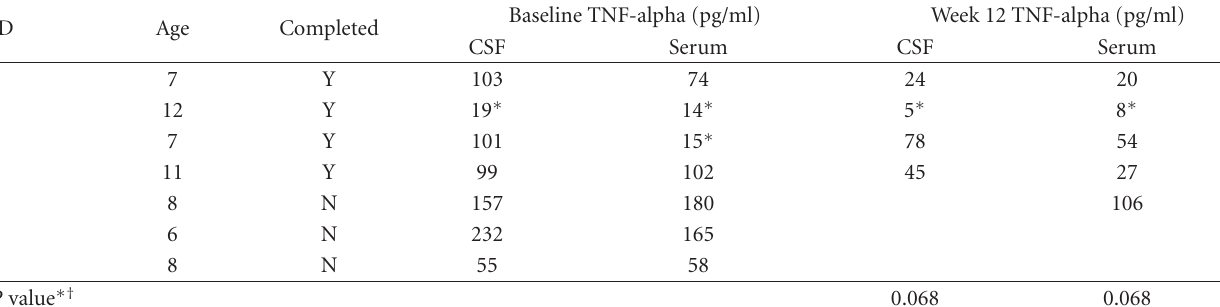
Table 1: Demographic and TNF-alpha (pg/ml) data for study subjects.